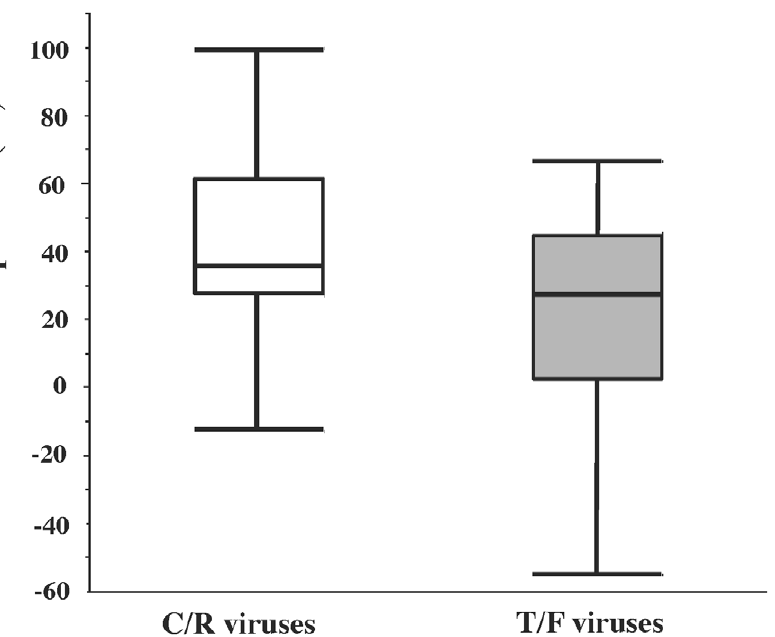
Figure 2. CD4 T cell depletion in C/R and T/F HIV-1 variants infected human cervical tissue exvivo . Blocks of human cervical tissue were infected with C/R or T/F viruses, and cultured ex vivo . 12 days post infection, the tissues were enzymatically digested and their cells were analyzed by polychromatic flow cytometry. T cells were identified by staining for CD3 and side-scatter. In this subset CD4 and CD8 were identified. The depletion of CD4 T cells was estimated by comparing the ratio of CD8 + to CD4 + (CD8 2 ) T cells in infected and uninfected controls, and expressing this ratio in infected tissue as a percent of the same ratio in matched uninfected control. Data showing individual experiments and summary box plots for n=19 and n=14 (median, 25 th and 75 th percentiles, and range of CD4/CD8 ratios in tissues infected with C/R viruses (empty boxes) and in tissues infected with T/F viruses, (filled boxes) are presented.